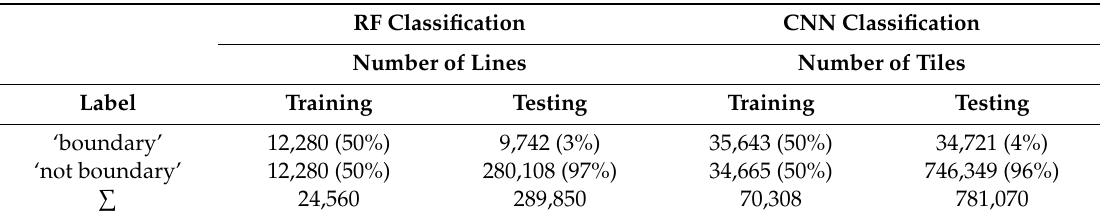
Table 1. Distribution of training and testing data for boundary classification based on Random Forest (RF) and Convolutional Neural Networks